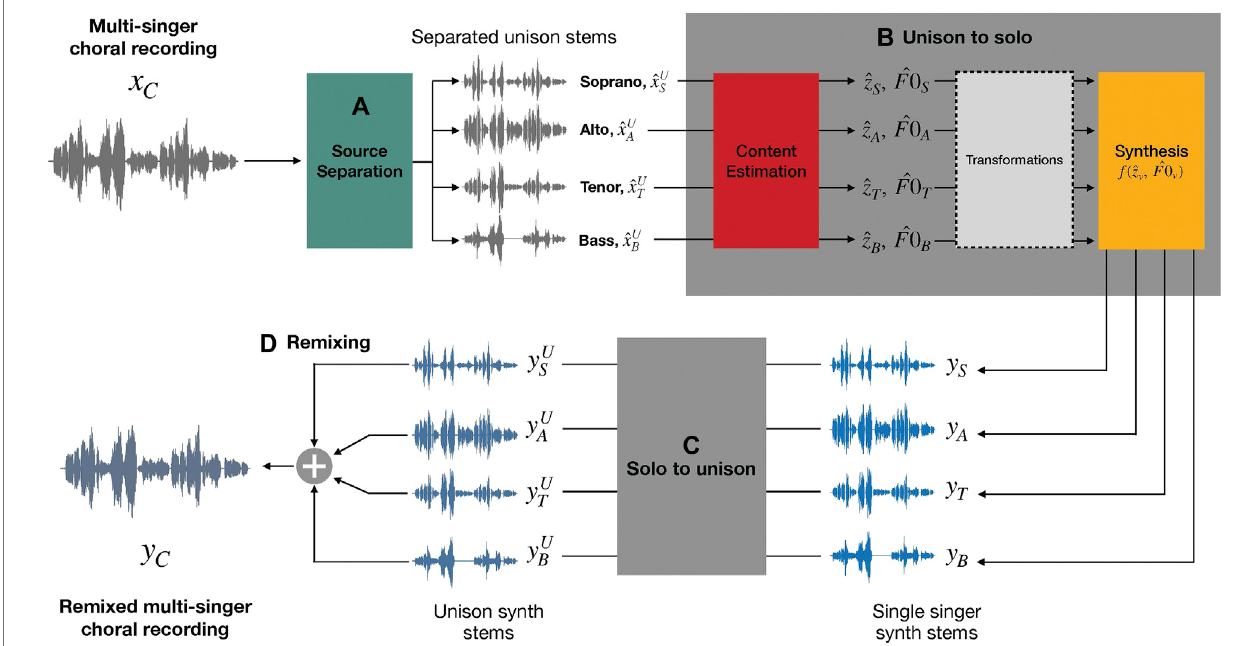
FIGURE 7 | Diagram of the full proposed framework. Given an input recording of a multi-singer choral recording, x C , the fi rst part of the paper proposes the use of (A) sourceseparationtechniquestoobtaineachunderlyingunisonstem, ^ x U v ,where v ∈ { S , A , T , B }.Thesecondpartofthisworkfocusesontheanalysisandsynthesisof unisons, which we present as a set of applications that include (B) unison to solo, with optional audio transformations like pitch-shifting, (C) solo to unison, and (D)